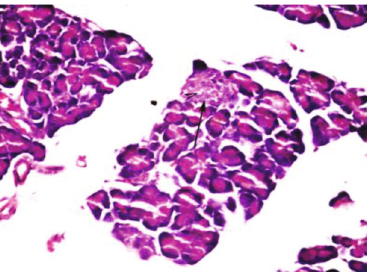
Figure 2: Photomicrograph of pancreatic tissue of STZ animal showing pancreatic islet reduced in size and cellularity with vacuolation between cells (arrowhead) (H&E) ( × 400).